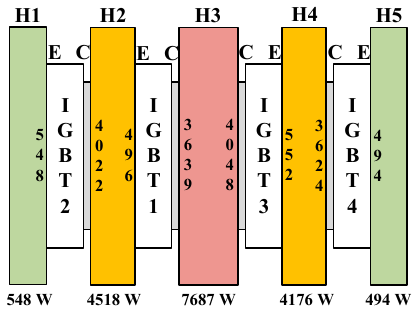
Figure 16. Power loss distribution of MMC-FBSM power stack.